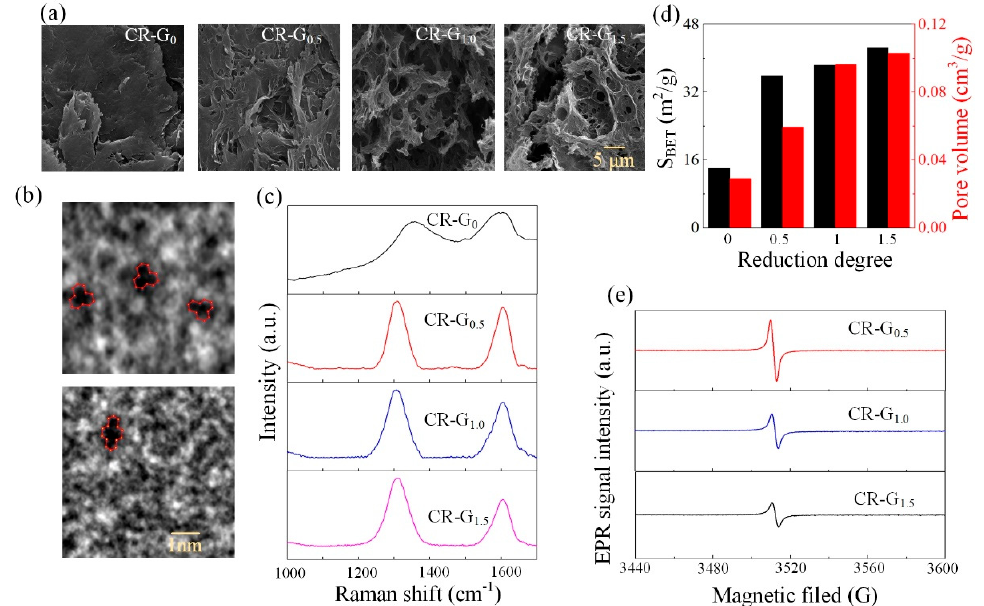
Figure 2. Characterization of the constructed chemically reduced graphene oxide (CR-G). ( a ) The scanning electron microscopy (SEM) of CR-G nanomaterials with different reduction degrees. ( b ) HR-TEM images of CR-G 1.5 graphene oxide with single-vacancy and double-vacancy defect. ( c ) The Raman spectra of CR-G nanomaterials with different reduction degrees. ( d ) The specific surface area (SBET) and the pore volume of the CR-G nanomaterials with different reduction degrees. ( e ) The electron paramagnetic resonance (EPR) spectrum of CR-G nanomaterials with different reduction degrees.